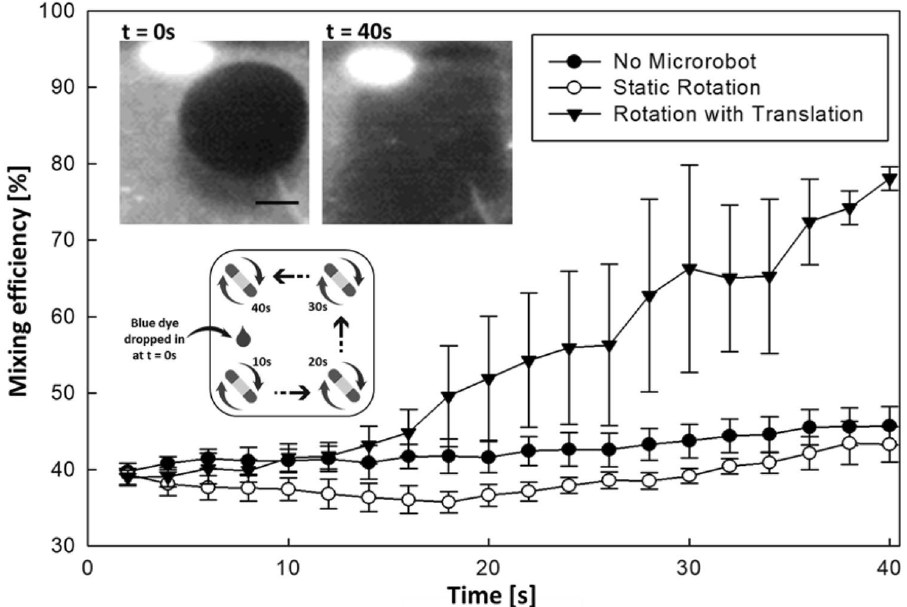
Figure 3. Effects of the magnetic actuation on the mixing efficiency in the absence of microrobot (mode I), under static rotation (mode II), and rotation with translation (mode III). In the top-left, Microphotographs (time-lapse snapshots) captured during moving speed edge to edge moving speed for mixing enhancement at t = 0 s and t = 40 s. In the bottom-left, Schematic illustration of the microrobot’s motion (edge-to-edge rotation with translation motion) in water under a rotating magnetic field for various time period (t = 10, 20, 30, and 40 s). Error bars represent one standard deviation in either direction from three repeated trials. Scale bar is 1 mm.